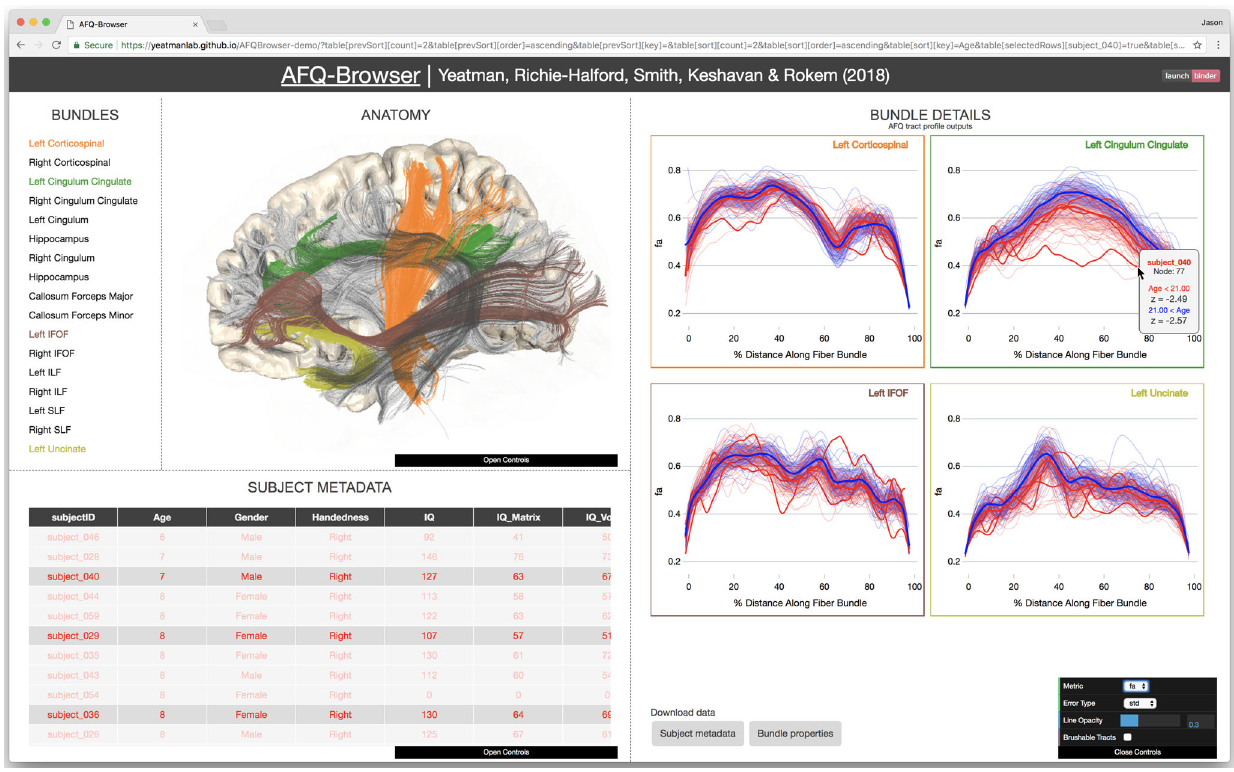
Fig. 6 AFQ-Browser. The BUNDLES panel displays the names of the tracts and the colors are linked to the ANATOMY and BUNDLE DETAILS panels. Selecting a tract in the BUNDLES or ANATOMY panel will display the Tract Pro fi le in the BUNDLE DETAILS panel. Selecting an individual subject ’ s Tract Pro fi le will highlight that subject in the SUBJECT METADATA panel. Selecting a column of SUBJECT METADATA groups subjects based on this measure. In the example, subjects are grouped based on age and means and standard deviations are shown in the BUNDLE DETAILS panel. When the mouse hovers over a selected subject ’ s Tract Pro fi le, z -scores are displayed for that subject relative to the First, color is used to identify each fi ber tract (here referred to as “ Bundle ” ) across the Bundle List, 3D Brain visualization, and Bundle Details plots. We use the categorical Tableau-20 color scheme (https://www.tableau.com/about/blog/2016/7/ colors-upgrade-tableau-10-56782). Clicking on a tract in the Bundle List, or 3D Brain, will highlight that tract in both panels and open up the corresponding line plot showing diffusion properties of that tract for each subject. Second, the Tract Pro fi les from each individual subject in the Bundle Details panels are linked to their metadata. Selecting a Tract Pro fi le (line) in the Bundle Details plot will highlight that subject ’ s row of the metadata table, and selecting a row of the metadata table will highlight that subject ’ s Tract Pro fi le in the plot. A subject of interest can be selected based on their metadata to visualize their Tract Pro fi les relative to the group of other subjects, or a Tract Pro fi le of interest can be selected to compare their metadata against the group of other subjects. Z -scores are displayed on mouse hover over for selected Tract Pro fi les, providing a statistical summary of an individual ’ s data relative to the group. Third, columns in the Metadata table are linked to mean lines in the Bundle Details plots. Clicking a column will sort the metadata table based on the data in that fi eld, and subjects will be divided into N groups by binning the data (the number of groups can be de fi ned in a control bar). Each bin will be assigned a color and this color will be used for the rows of the metadata table, the mean lines in the Bundle Details plot, and the individual subject lines in the plot. Each time a new column in the metadata is selected, the mean lines are updated in the plot, and the rows are sorted and colored appropriately in the metadata table. This feature provides an ef fi cient tool to slice a large data set across different dimensions, examine how different subject characteristics relate to diffusion measures, determine subjects that are outliers within a group, and determine how different manners of grouping produce changes across different white matter fi ber tracts. Subject z -scores are updated based on the grouping. Fourth, the spatial dimension ( x -axis) of the Bundle Details plots is linked to the fi ber tracts in the 3D brain visualization. Manual selection ( brushing 64 ) of a range of nodes in the Bundle Details plot, enabled by toggling on the brushable tracts feature in a control bar, highlights the corresponding region of the fi ber tract in the 3D brain. This feature allows a user to link statistics, group differences, or quantitative comparisons of an individual subject back to their brain anatomy.